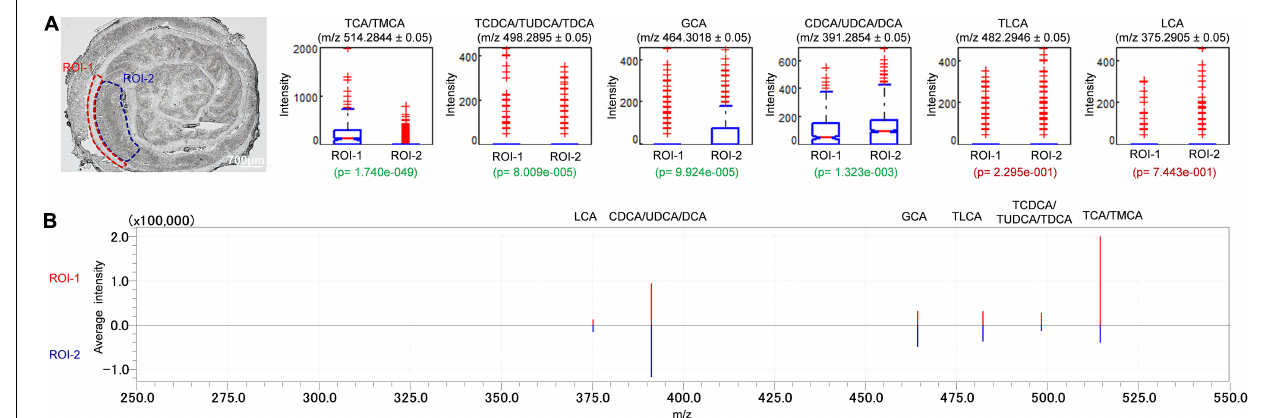
FIGURE 5 | Distribution profiles of BAs in colon were studied through comparison of relative intensities of BAs by the values of p between ROI-1 and ROI-2. Signal intensities of targeted BAs in ROI of two different regions of colon were depicted and signal normalization was performed by pixel. ROI-1: submucosa, muscular layer and adventitia; ROI-2: mucosa layer. The letter ‘ p ’ denotes the statistical p -value of the comparison, significant differences were highlighted in green font while insignificant differences were highlighted in red font (A) . The spectrum of each ROI which set in (A) . The spectra were vertically inverted, with that of ROI-1 above in red and that of ROI-2 below in blue (B)